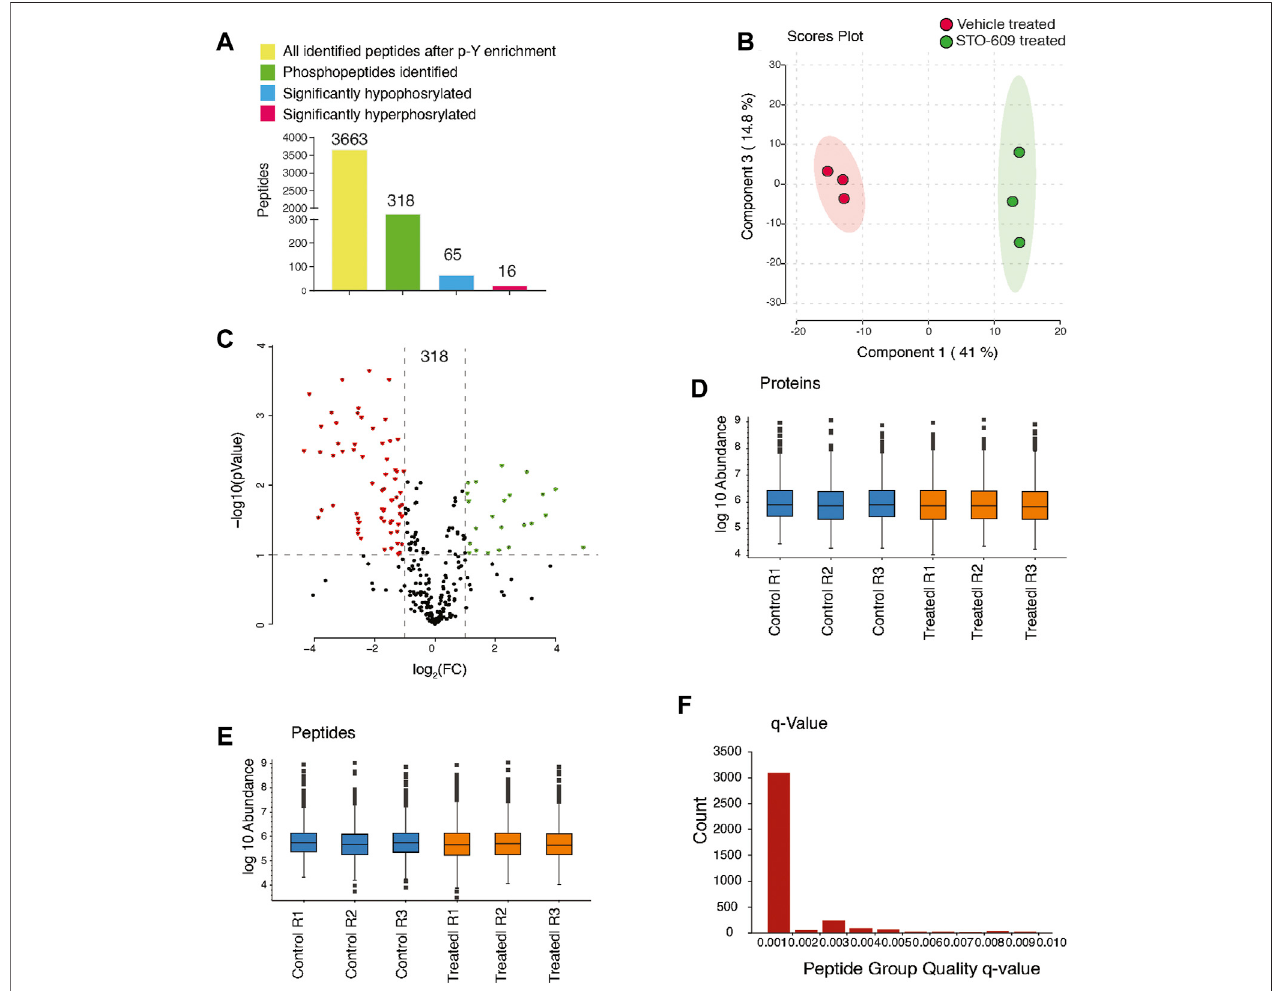
FIGURE 2 | Inhibition of CAMKK2 results in change in tyrosine phosphoproteome in gastric cancer cells. (A) Bar graph summarizes phospho-Y-proteomic changes in gastric cancer cells (AGS) treated with 18.5 μ M STO-609 and vehicle control. (B) Principal component analysis of control and CAMKK2-inhibited AGS cells. (C) Volcano plot showing the distribution ofphosphopeptides upon STO-609 treatment 18.5 µM for 2 h. (D) Boxplot showing the sum ofprotein abundances between the control and STO-609 – treated AGS cells across the triplicates. (E) Box plot showing the sum of peptides abundances between the control and STO- 609 – treated AGS cells across the triplicates. (F) The bar graph shows the q-value of peptides.